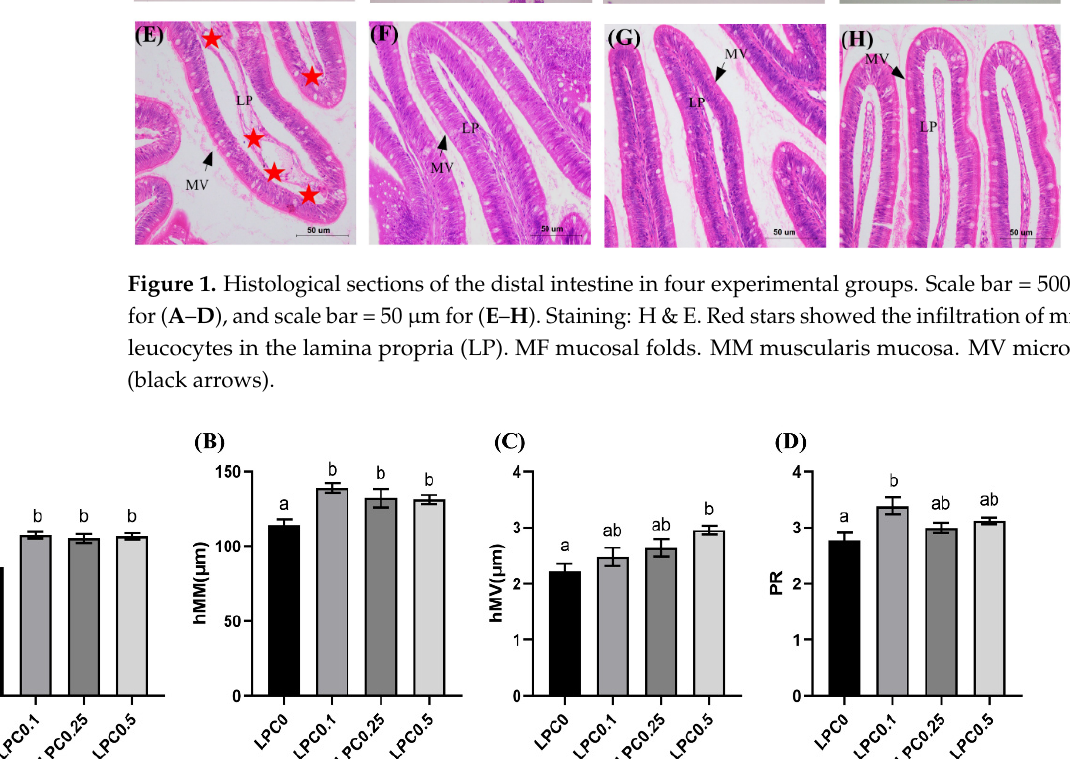
Figure 1. Histological sections of the distal intestine in four experimental groups. Scale bar = 500 μ m for ( A – D ), and scale bar = 50 μ m for ( E – H ). Staining: H & E. Red stars showed the infiltration of mixed leucocytes in the lamina propria (LP). MF mucosal folds. MM muscularis mucosa. MV mi- crovilli (black arrows).